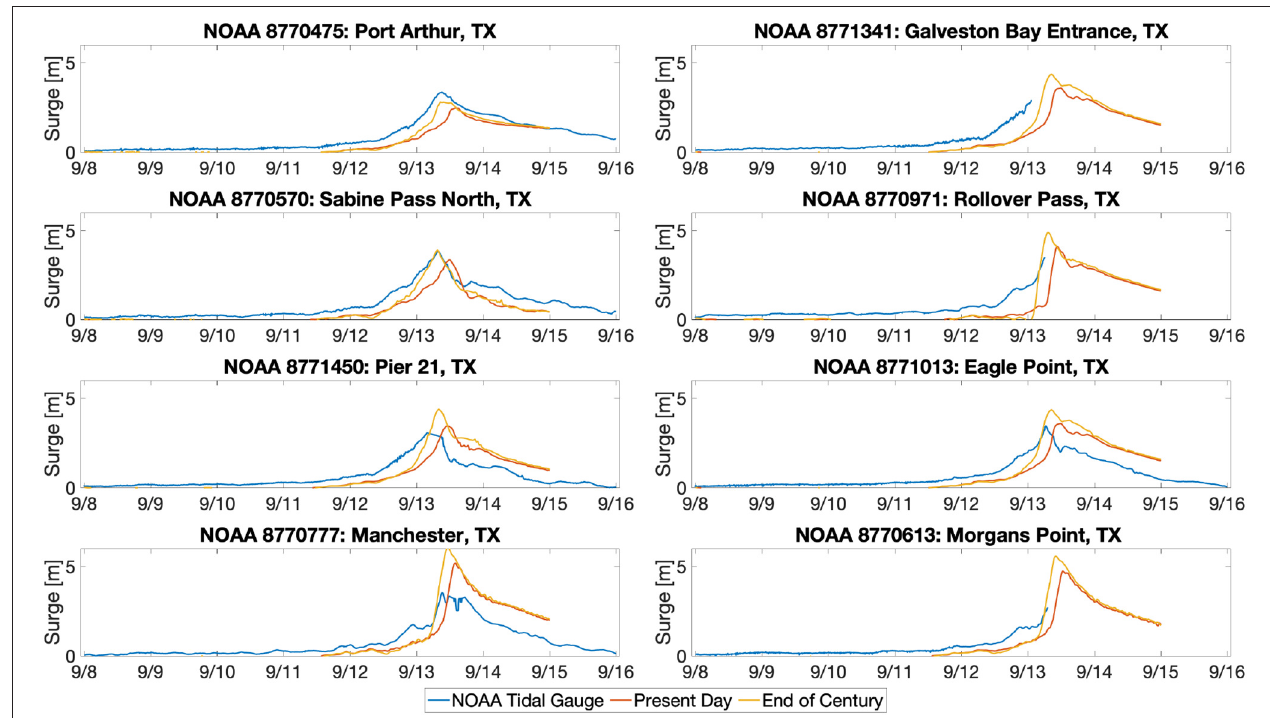
FIGURE 12 | Time series of water levels recorded at NOAA tide gauges that lie within 100 km of Hurricane Ike at landfall (blue) and data from the present day (red) and end of century (yellow) WRF-ADCIRC simulations. Note that several gauges failed prior during peak storm conditions.